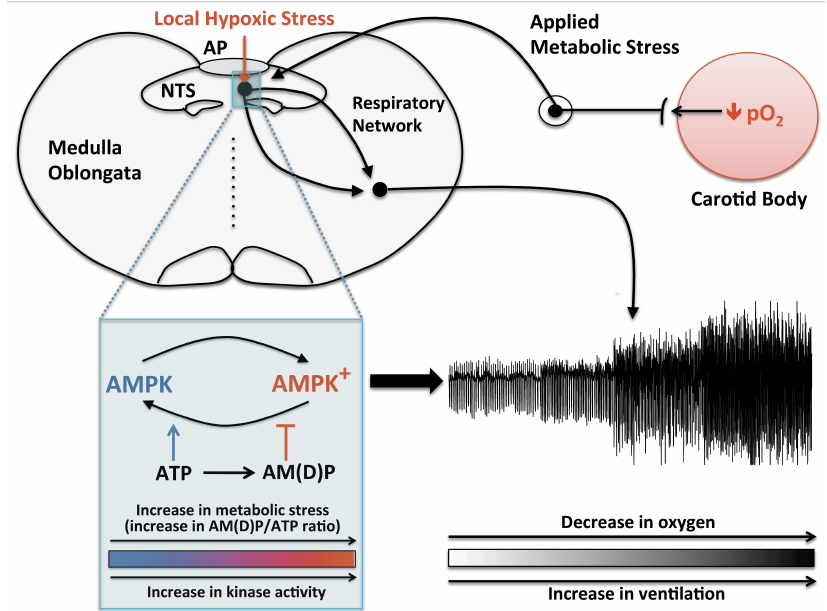
Figure 3. One, two, three o’clock, four o’clock breathe. Schematic describing the new hypothesis on the regulation by AMPK of the hypoxic ventilatory response, through the integration of local and applied metabolic stresses. AP = area postrema; NTS = nucleus tractus solitarius. From [107], created by the Evans laboratory and redrawn by Evans